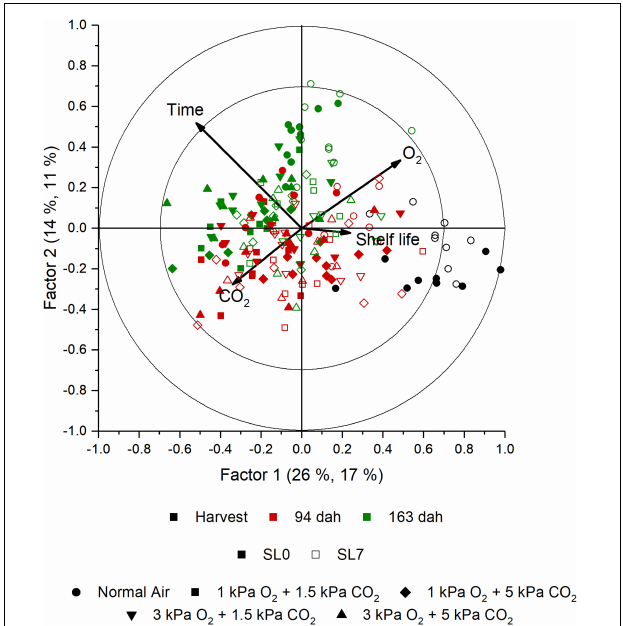
FIGURE 7 | Score plot of factor 1 and 2 obtained with the PLS analysis of the aroma measurement of the cabbage juice using SPME GC-MS. Between the brackets per factor, the first percentage indicates the percentage of which part of the aroma variables are represented in the projection of this dimension, while the second percentage indicates to what extent the response is explained by this. The different objects are color- and shape-coded based on time and treatment, respectively, as indicated in the legend. At each time point, shelf life and storage treatment, nine biological replicates were